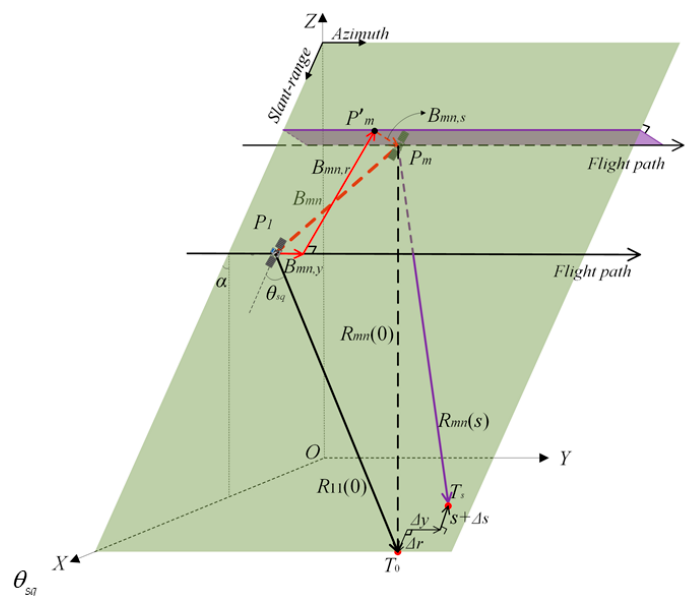
Figure 2. Squinted synthetic aperture radar (SAR) data acquisition geometry for the improved D-TomoSAR.